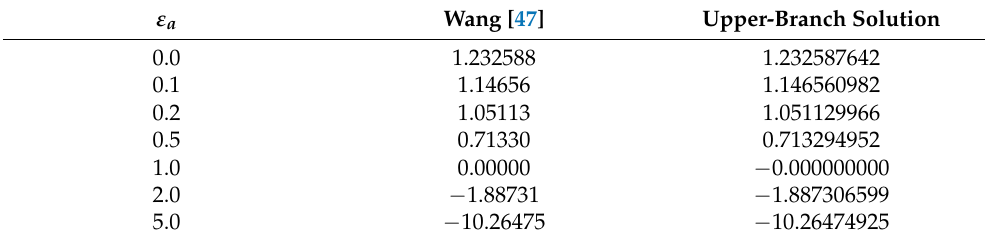
Table 2. Comparison values of the friction factor for several values of the stretching with parameter ε a . ε a Wang [47] Upper-Branch Solution 0.0 1.232588 0.1